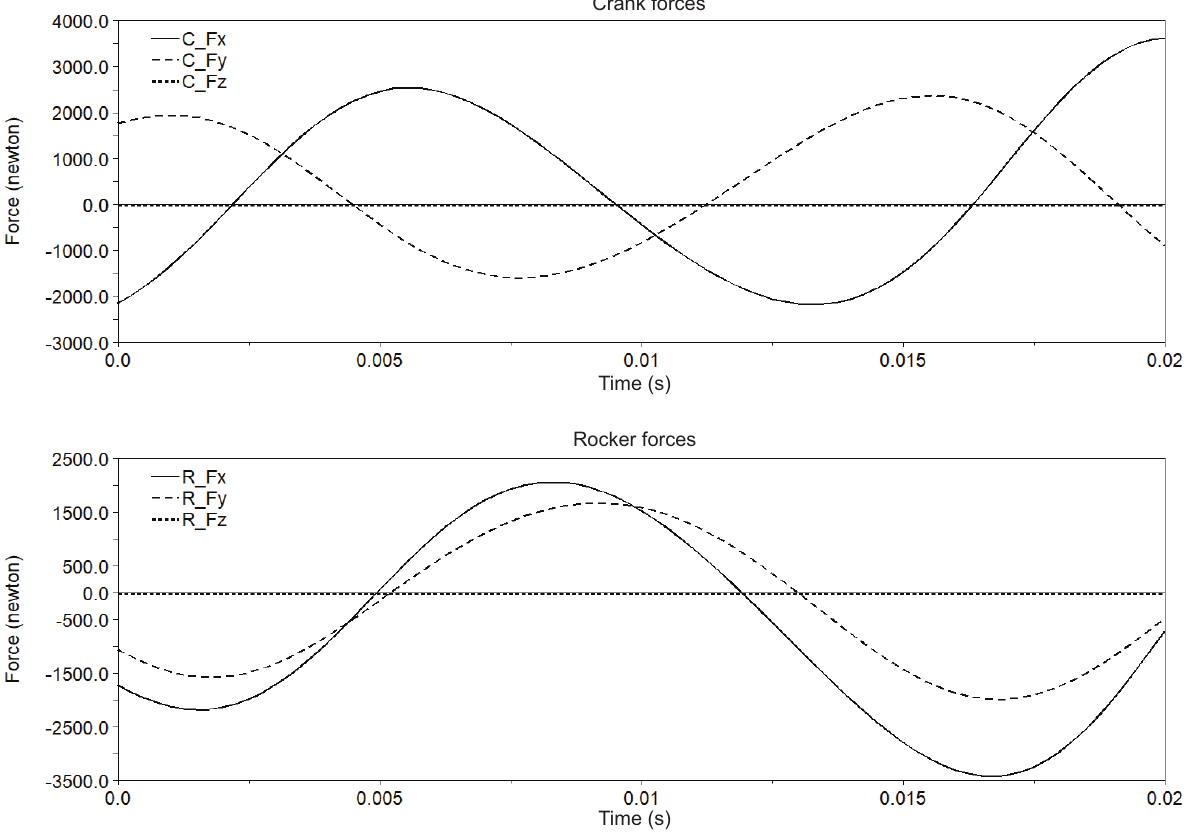
Fig. 2. Crank and rocker shaking